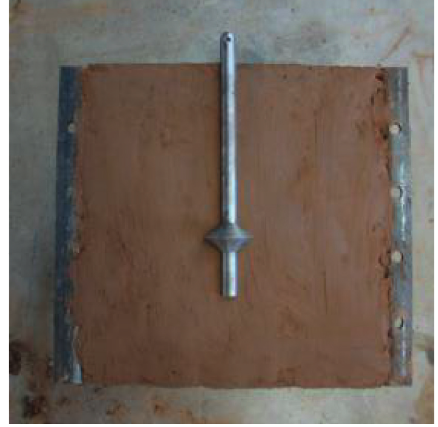
Figure 11: Burying a